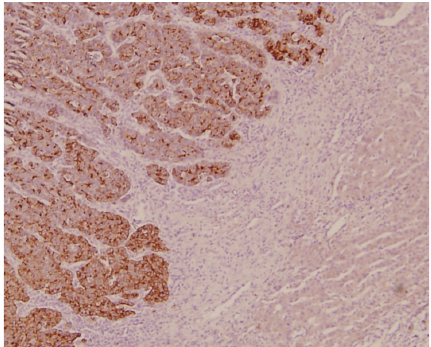
Figure 2: The tumor cells expressing strong immunoreactivity for neuron specific enolase (NSE), while the surrounding hepatocytes are negative.